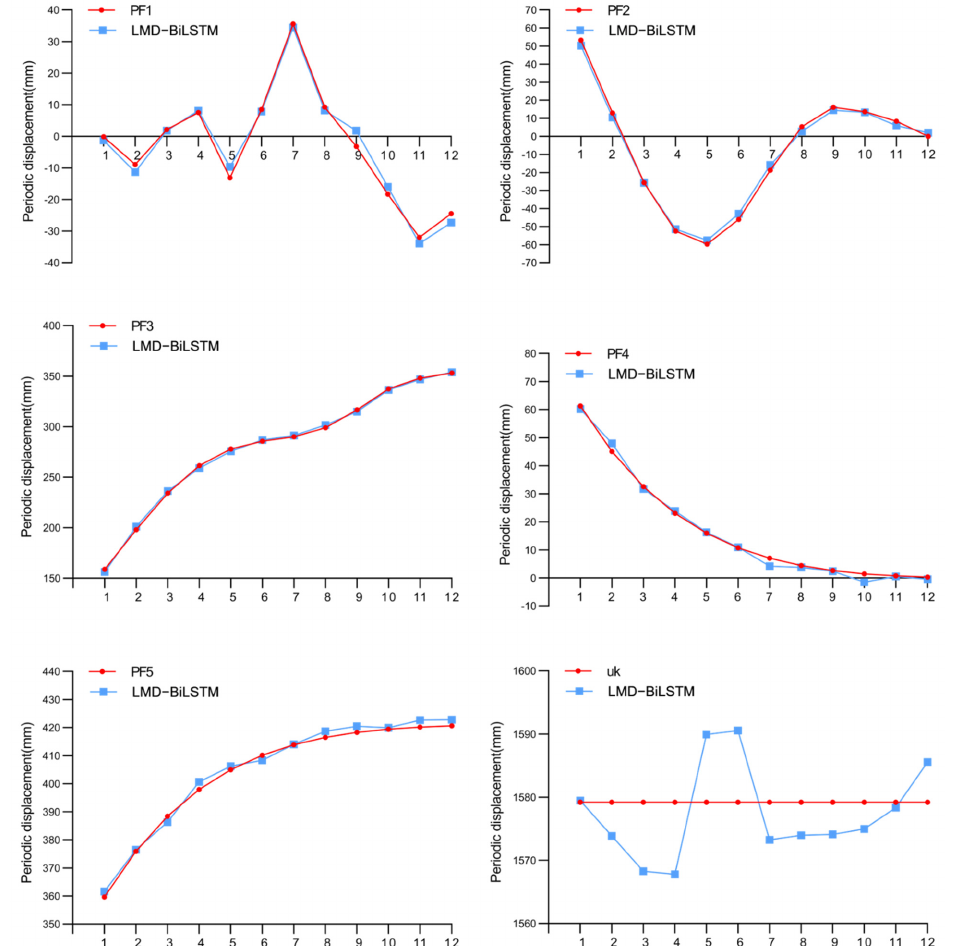
Figure 7. The components of the landslide displacement prediction results. After the six components of landslide displacement are predicted, they are summed to obtain the final prediction result, as shown in Figure 8.